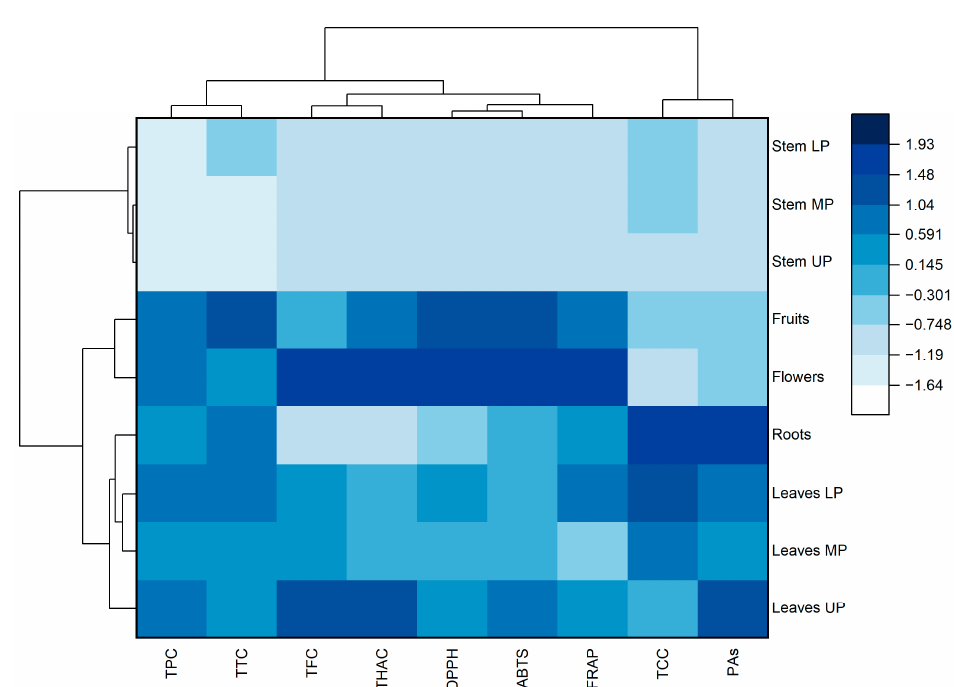
Figure 2. Heat map with clusters of the studied phytochemical parameters (at the ( top )) and meadowsweet samples (on the ( left )). TPC—total phenolic content; TFC—total flavonoid content; THAC—total hydroxycinnamic acid content; TCC—total catechin content; PAs—total proanthocyanidin content; TTC—total tannin content; DPPH—antioxidant activity determined by DPPH (2,2-diphenyl-1-picrylhydrazyl) assay; ABTS—antioxidant activity determined by ABTS (2,2 ′ -azino-bis(3-ethylbenzothiazoline-6-sulfonic acid)) assay; FRAP—ferric-reducing antioxidant power; LP, MP,